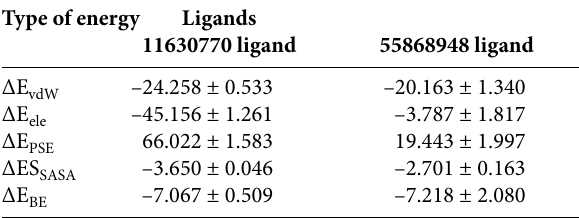
Table 9. Binding free energy (kcal mol –1 ) for the interaction of pro- tein with 11630770 and 55868948 ligands using MMBSA